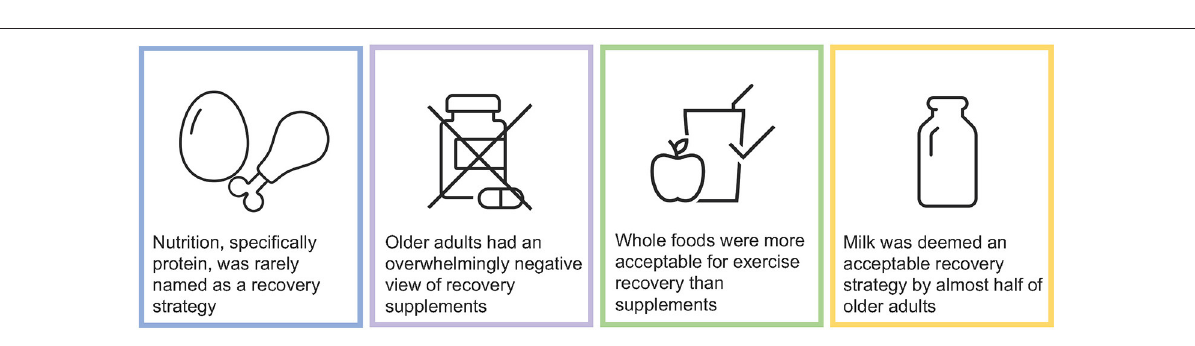
FIGURE 3 | Summary of main